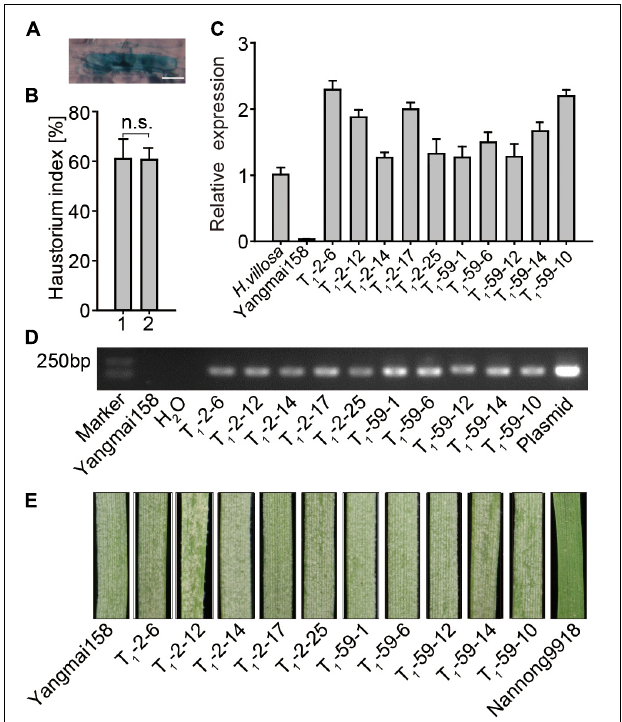
FIGURE 5 | Functional analysis of EXO70E1-V in powdery mildew ( Pm ) resistance. (A) Examples of β -glucuronidase ( GUS ) staining and haustorium, scale bar = 20 µ m. (B) Transient overexpression assay (TOA) of EXO70E1-V . 1 and 2 represent vectors GUS alone and GUS + EXO70E1-V, respectively. Haustorium index is the percentage of GUS -stained cells having haustorium in the total GUS -staining cells attacked by Bgt . Each column represents the means ± SD. n.s. represents not significant. (C) EXO70E1-V expression in H. villosa , receptor Yangmai158, and two T 1 transgenic lines (T 1 -2 and T 1 -59). The expression levels were normalized to Tubulin , and H. villosa is set as “1.” (D) Amplification for EXO70E1-V in T 1 transgenic lines. Yangmai158 and H 2 O were negative controls, and plasmid pBI220-EXO70E1-V was used as a positive control. Marker: DL2000 DNA ladder. (E) Observation of Pm spores on leaves. Yangmai158 and Nannong9918 were used as susceptible and resistant control, respectively.